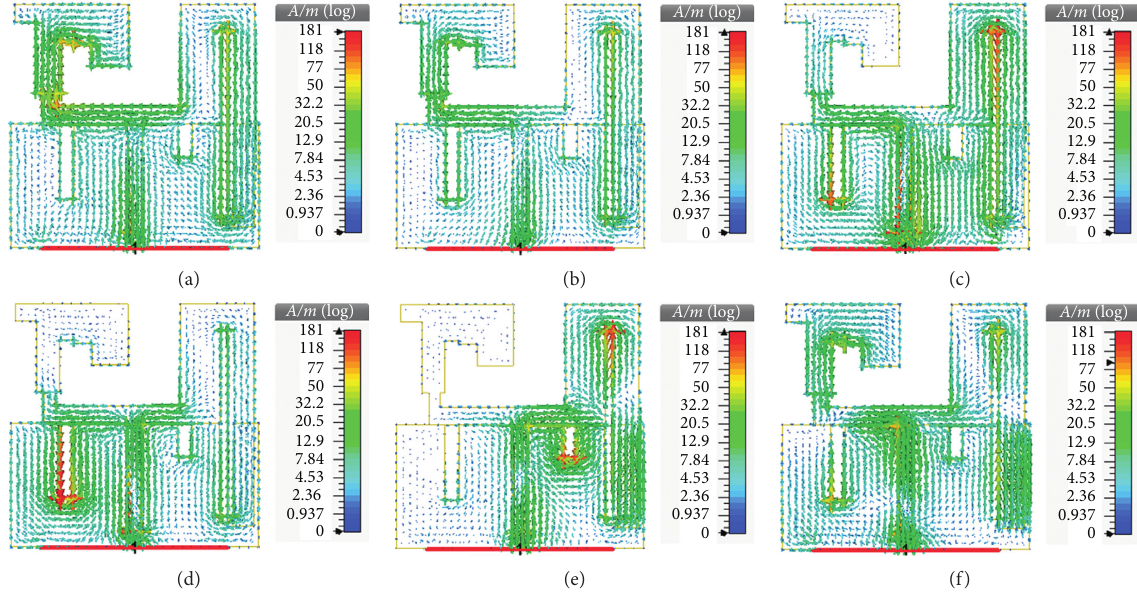
Figure 11: Current distribution per frequency: (a) 2.3GHz, (b) 2.4GHz, (c) 2.6 GHz, (d) 3.5GHz, (e) 5.2GHz, and (f)